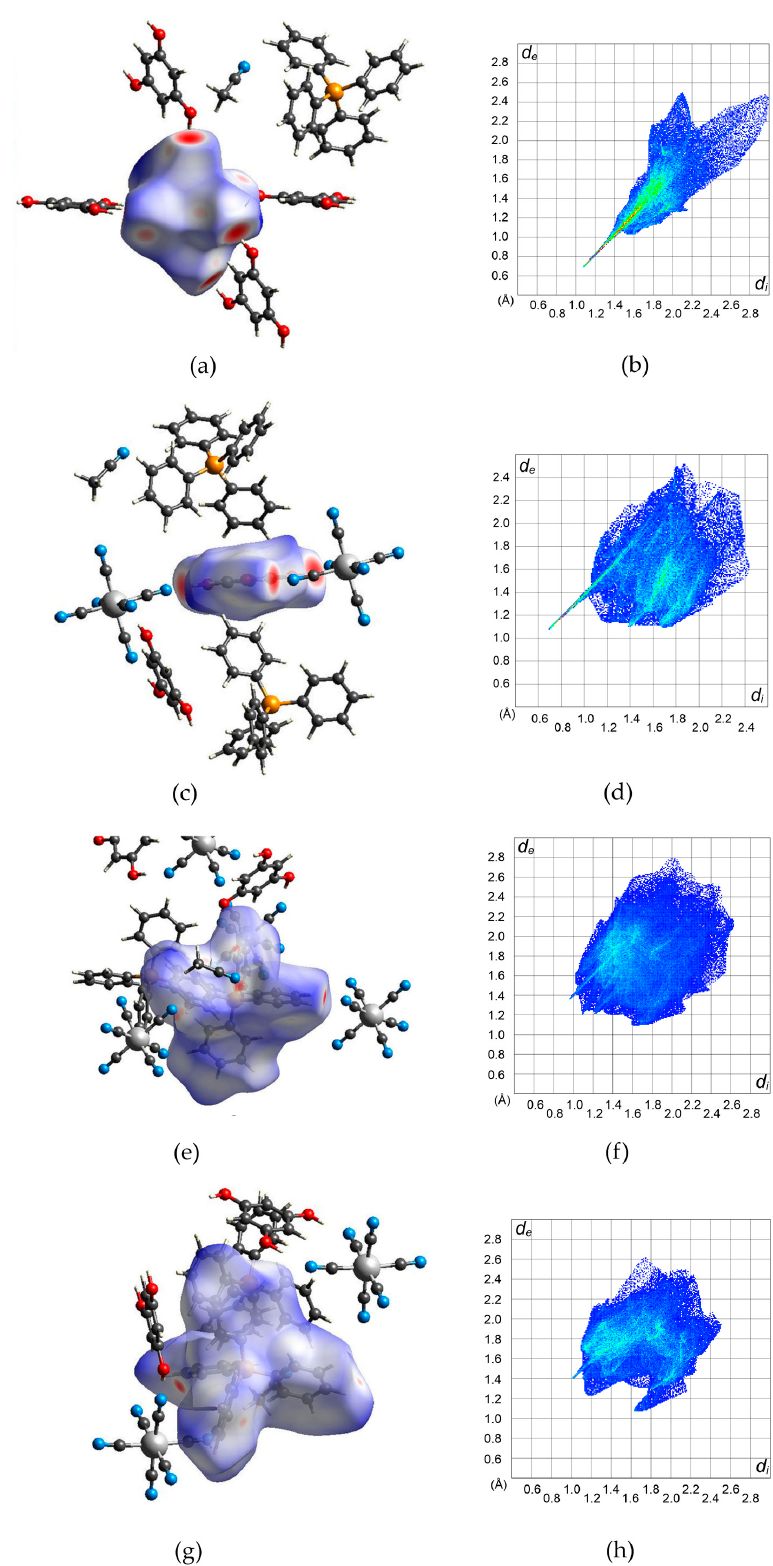
Figure 2. Hirshfeld surfaces ( left column ) of the molecular building blocks in 2 and corresponding 2 fingerprints ( right column ) for all interactions: ( a , b )–[Fe(CN) 6 ] 3 − ; ( c , d )–H 3 PG; ( e , f )–P(1)Ph 4 + ; ( g , h )– P(2)Ph 4 + . The detailed images for all individual interactions are given in the Supplementary Materials (Figures S6, S7, S9 and